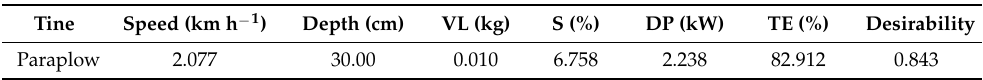
Figure 9. 3D surface curves of traction efficiency as influenced by interactions between input parameters using the RSM approach; ( a ) tine and depth, ( b ) tine and speed, ( c ) tine and vertical load, ( d ) depth and speed, ( e ) speed and vertical load. Table 5. Regression equations of response